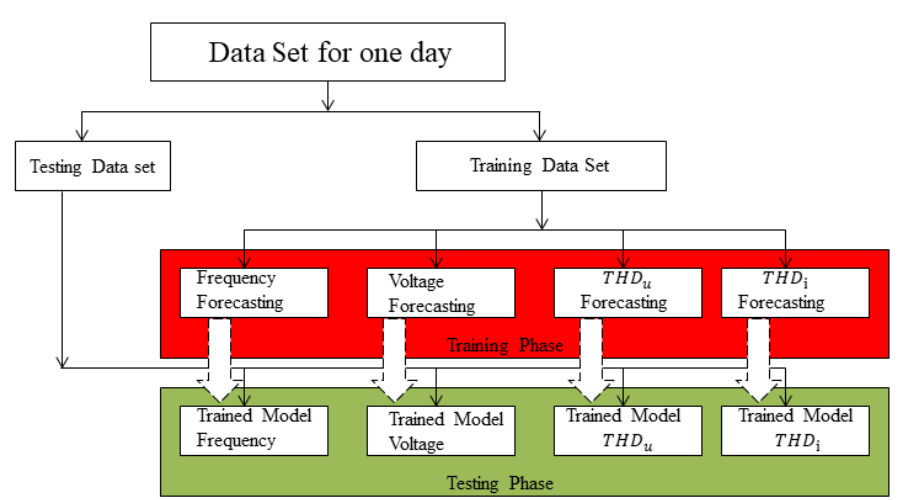
Figure 4. Flowchart of the designed model. The experiment procedure was done the same way as in this flowchart for all days and for all